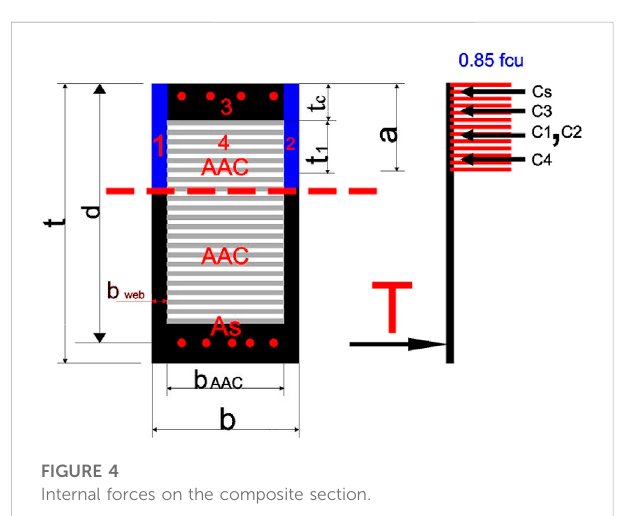
Internal forces on the composite